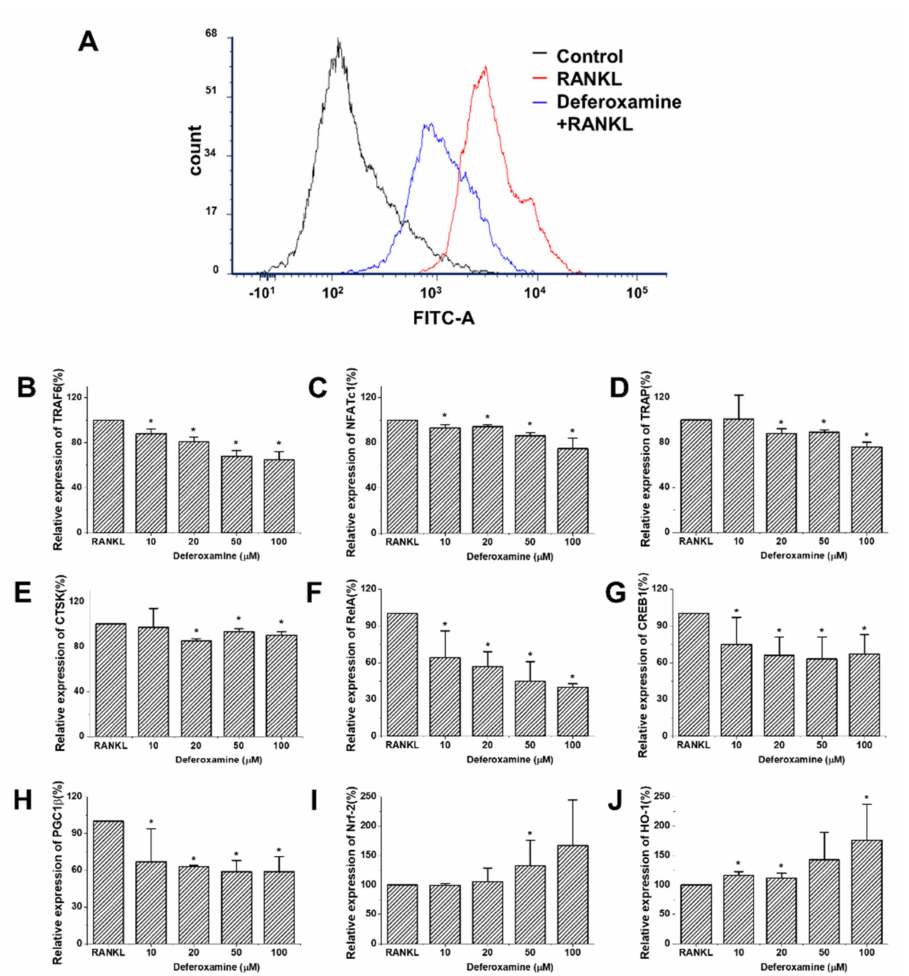
Figure 3. Intracellular reactive oxygen species and related genes with osteoclast differentiation treated with DFO in RAW264.7 cells. ( A ) Intracellular ROS levels determined using an H 2 DCFDA ROS probe and analyzed with FCS express flow cytometry. ( B – J ) Changes in the expression of the osteoclast-related genes of DFO in RAW264.7 cells. Cells were pretreated with different con- centrations of DFO for 2 h followed by treatment with 50 ng/mL RANKL for 3 days. RNA was isolated from RAW264.7 cells, and cDNA was synthesized. Expression levels of tartrate-resistant acid phosphatase (TRAP), TNF receptor associated factor 6 (TRAF6), nuclear factor of activated T cell, cytoplasmic 1 (NFATc1), and cathepsin K (CTSK) were evaluated using quantitative RT-PCR relative to the RANKL treatment group (normalized to 100%). Expression levels of v-rel avian reticuloendotheliosis viral oncogene homolog A (RelA), cyclic AMP-responsive element-binding protein 1 (CREB1), peroxisome proliferator-activated receptor gamma coactivator-1beta (PGC-1 β ), heme oxygenase-1 (HO-1), and nuclear factor erythroid 2–related factor 2 (Nrf-2) were evaluated using quantitative RT-PCR relative to the RANKL treatment group (normalized to 100%). Data were obtained from five separate experiments, with all samples run in duplicate. The data are expressed as mean ± standard deviation values. The expression of the genes differed significantly; t-test and Mann–Whitney U test, * p <